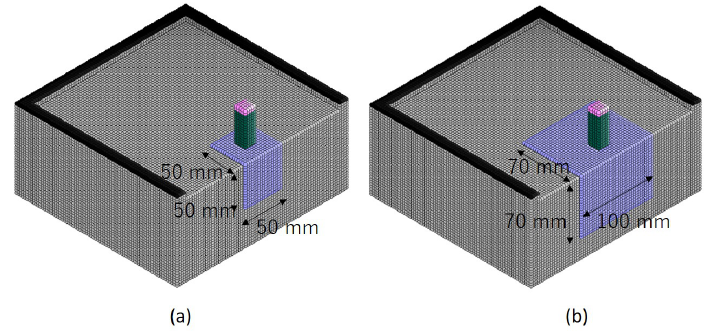
Figure 29. Analysis model with PCM reinforcement layer. ( a ) Model with PCM layer of small area. ( b ) Model with PCM layer of large area.